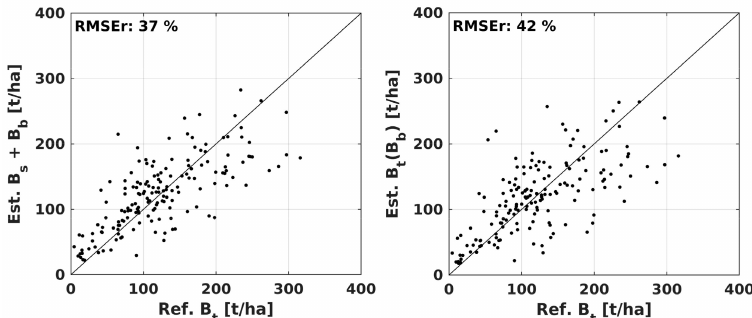
Figure 9. Comparison of in situ above-ground biomass with estimates obtained by summing independent radar-derived stem and branch biomass estimates ( left ), or by applying allometric relationships between radar-derived branch and above-ground biomass ( right